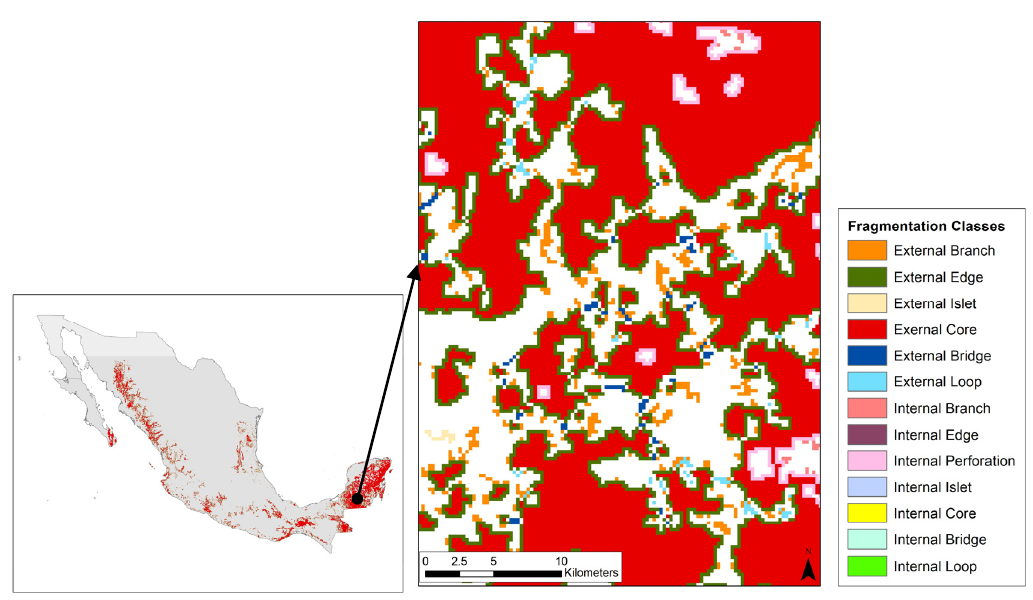
Figure 4. Sample of the map output of MSPA fragmentation classes generated with the intext parameter set to “On” for an area of the tropical forests in 2002.